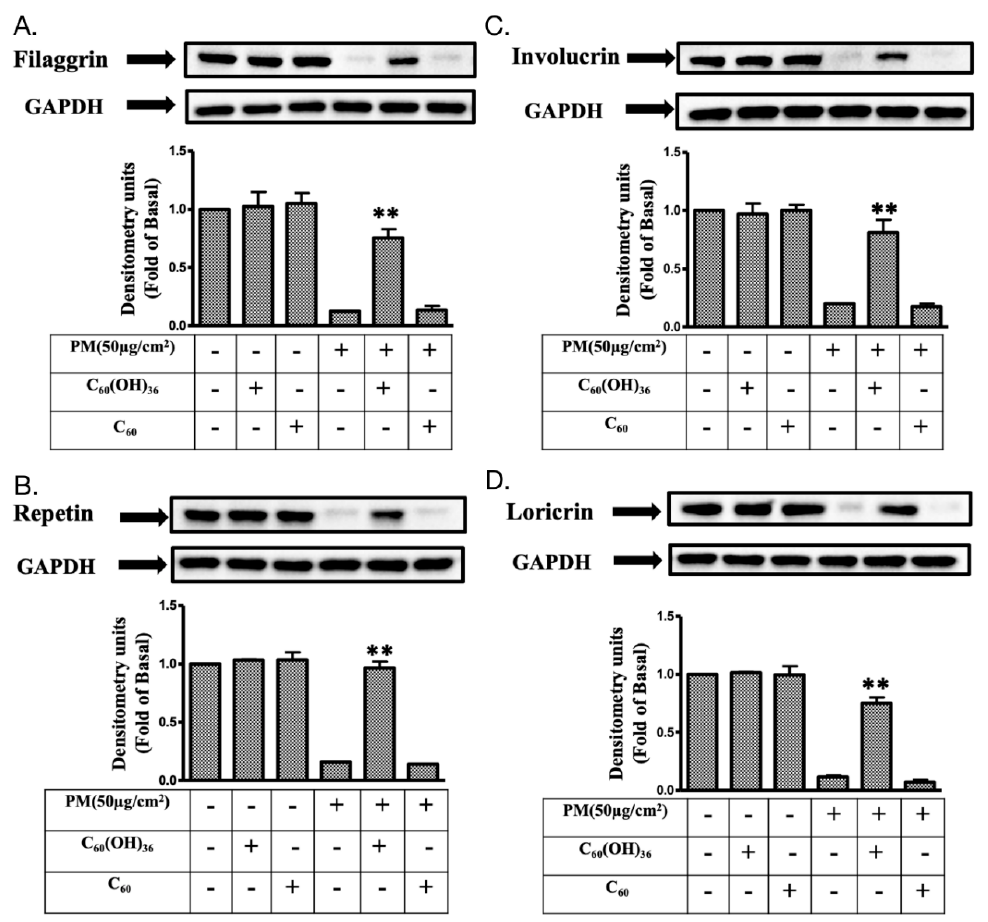
Figure 8. The expression levels of proteins exhibiting protective effects towards keratinocytes in fullerenol C 60 (OH) 36 and PM-treated HaCaT cells. The effects of proteins with protective effects, including ( A ) filaggrin, ( B ) repetin, ( C ) involucrin, and ( D ) loricrin, were measured by immunoblotting in HaCaT cells that did or did not receive pre-treatment with fullerenol C 60 (OH) 36 or fullerene C 60 dissolved in water for 1 h and with PM (SRM 1649b, 50 μ g/cm 2 ) for another 24 h. Glyceraldehyde 3-phosphate dehydrogenase (GAPDH) was used as a loading control. Blots were representative of three independent experiments, and data are expressed as mean ± SEM values. * p < 0.01, as compared to the values for the PM exposure group.